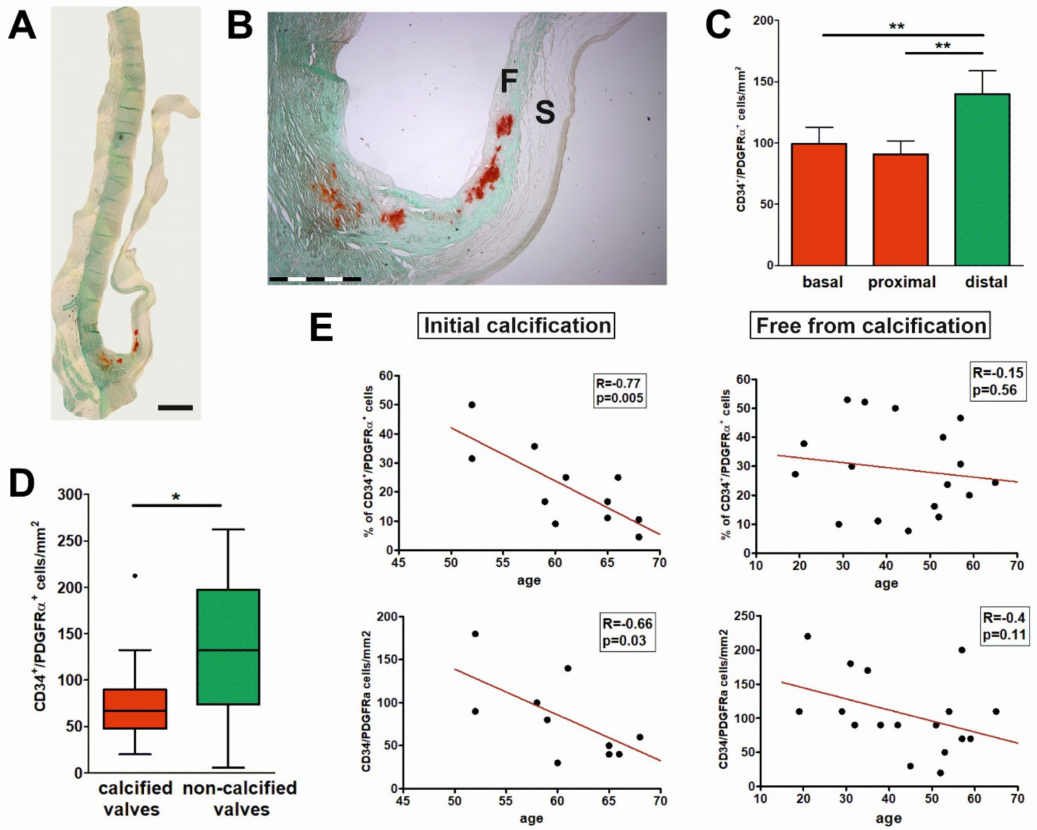
Figure 4. Association of CD34 +/ PDGFR α + cells with initial calcification in aortic valves. ( A )